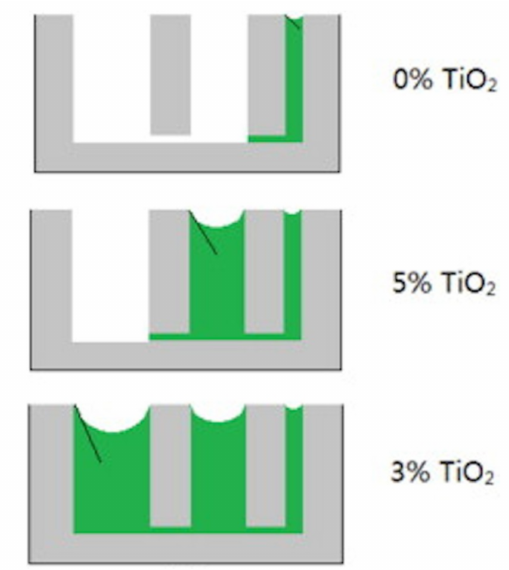
Figure 4. The sketch of the filling of water in the capillary pores before and after the addition of nano-TiO 2 in the cement composite. Reproduced from [34], with permission from Elsevier, 2019.